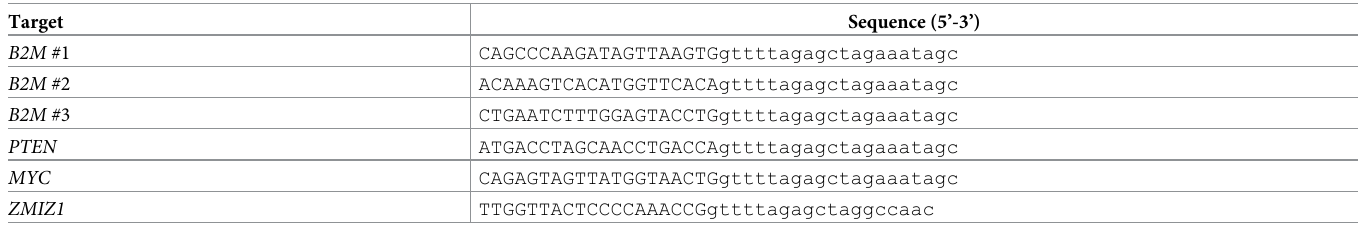
Table 1. Sequence of oligos used for creating sgRNA expression